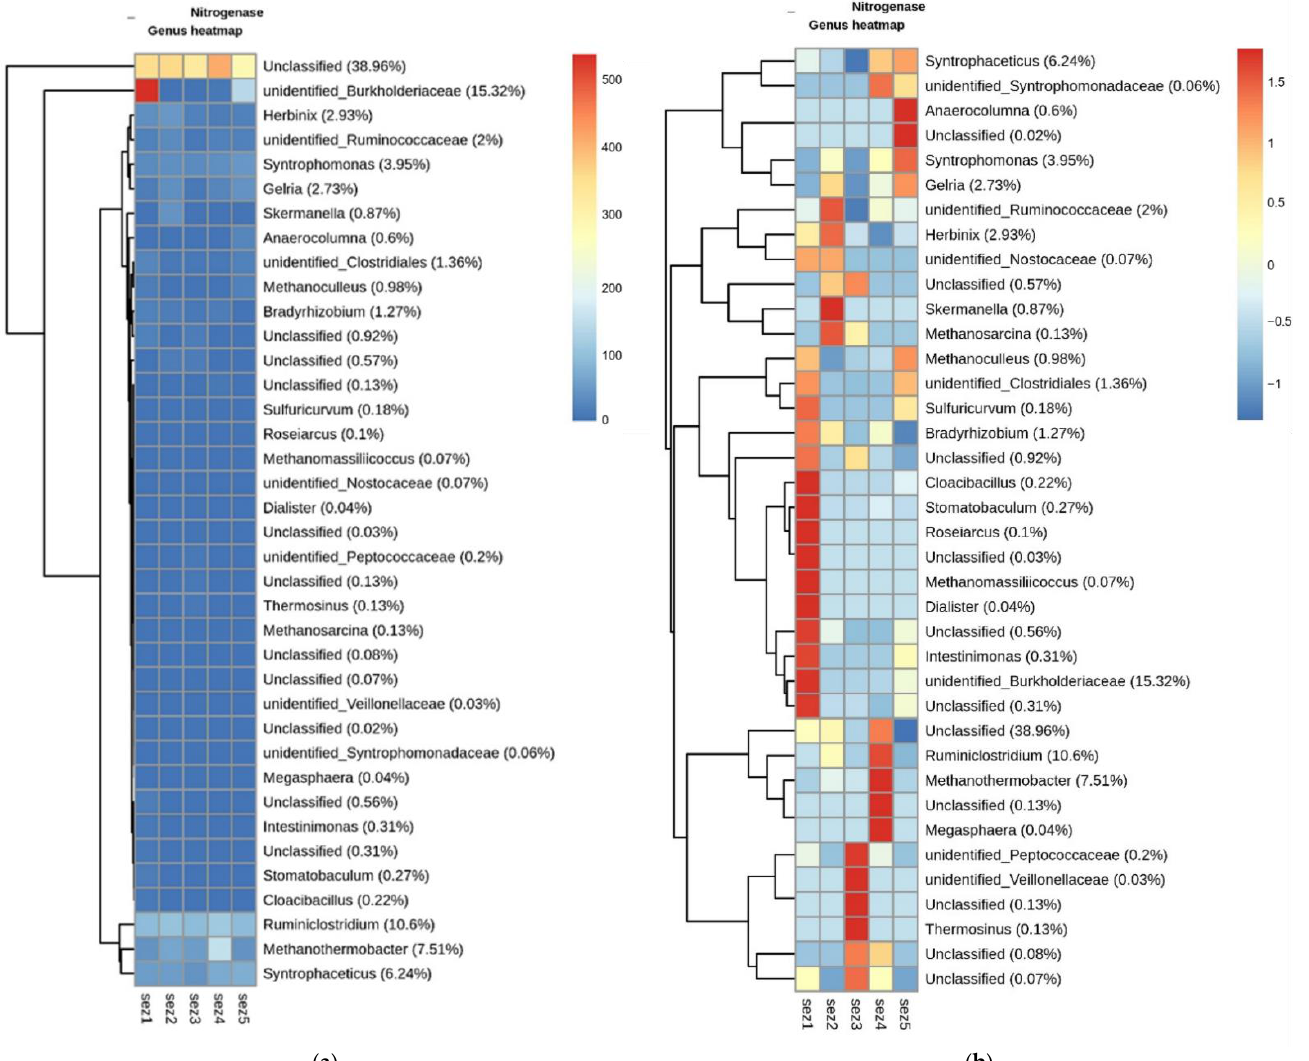
Figure A10. Functional heatmaps of nitrogenase: ( a ) absolute counts and ( b ) autoscaled counts, aggregated at the genus level.